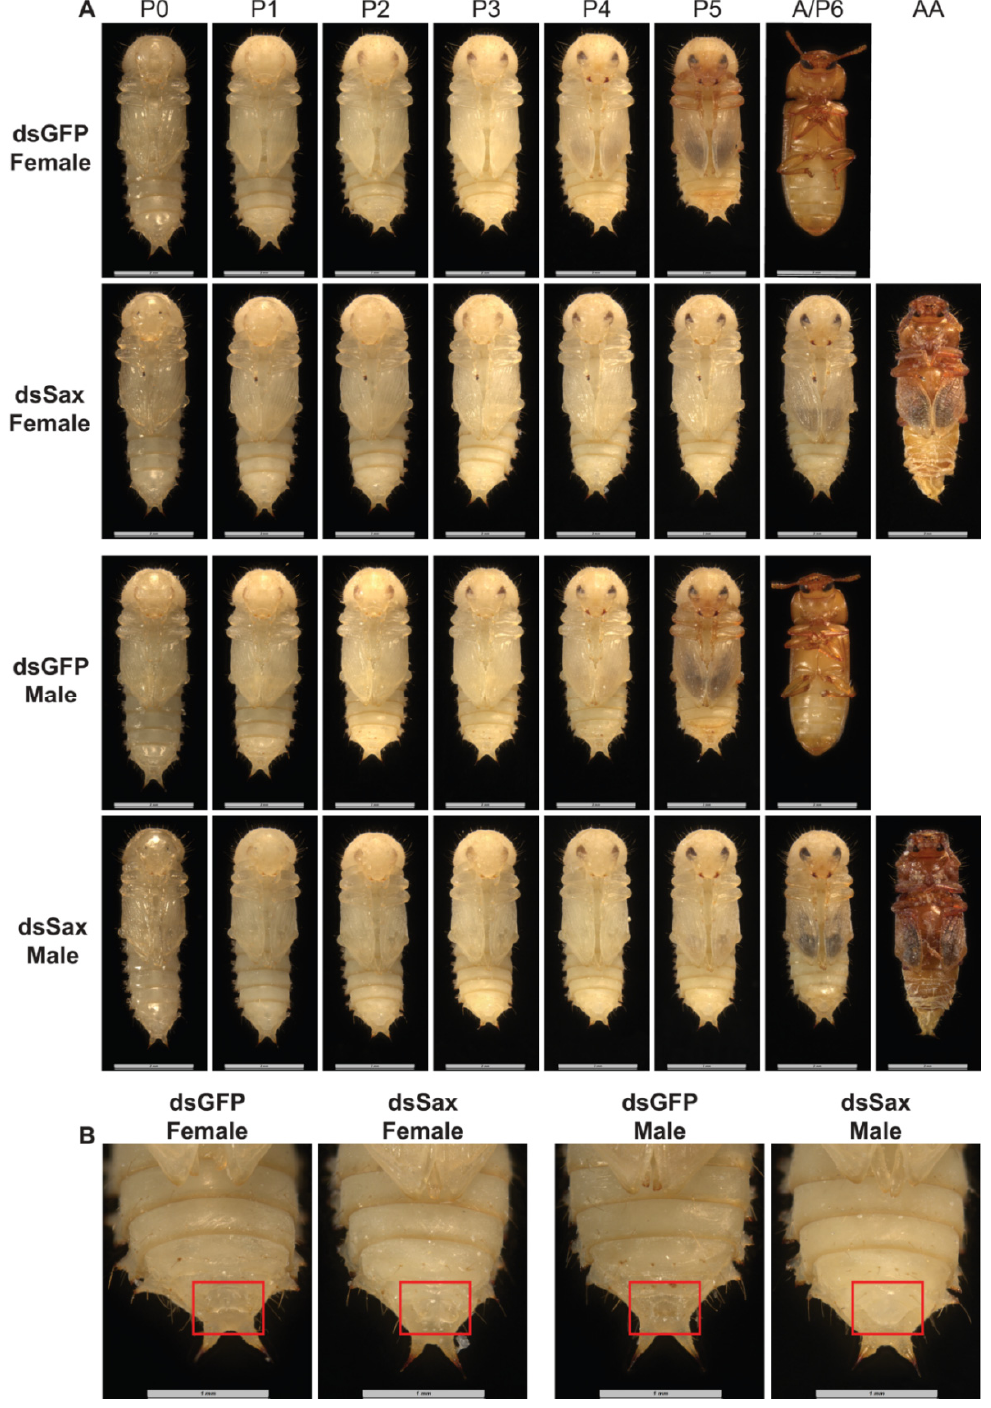
Figure 6. The ventral view of newly formed female and male pupae and adults from the dsGFP (100 ng/larva) and dsSax (100 ng/larva) groups. ( A ) The ventral view of newly formed female and male pupae and adults from the dsGFP and dsSax groups (P0: newly formed pupa; P1: 1-day pupa; P2: 2-day pupa; P3: 3-day pupa; P4: 4-day pupa; P5: 5-day pupa; P6: 6-day pupa; A: adult; AA: abnormal adult). ( B ) The ventral view of the enlarged female and male pupal abdomen in the dsGFP and dsSax treated groups. The red boxes indicate the genitals.